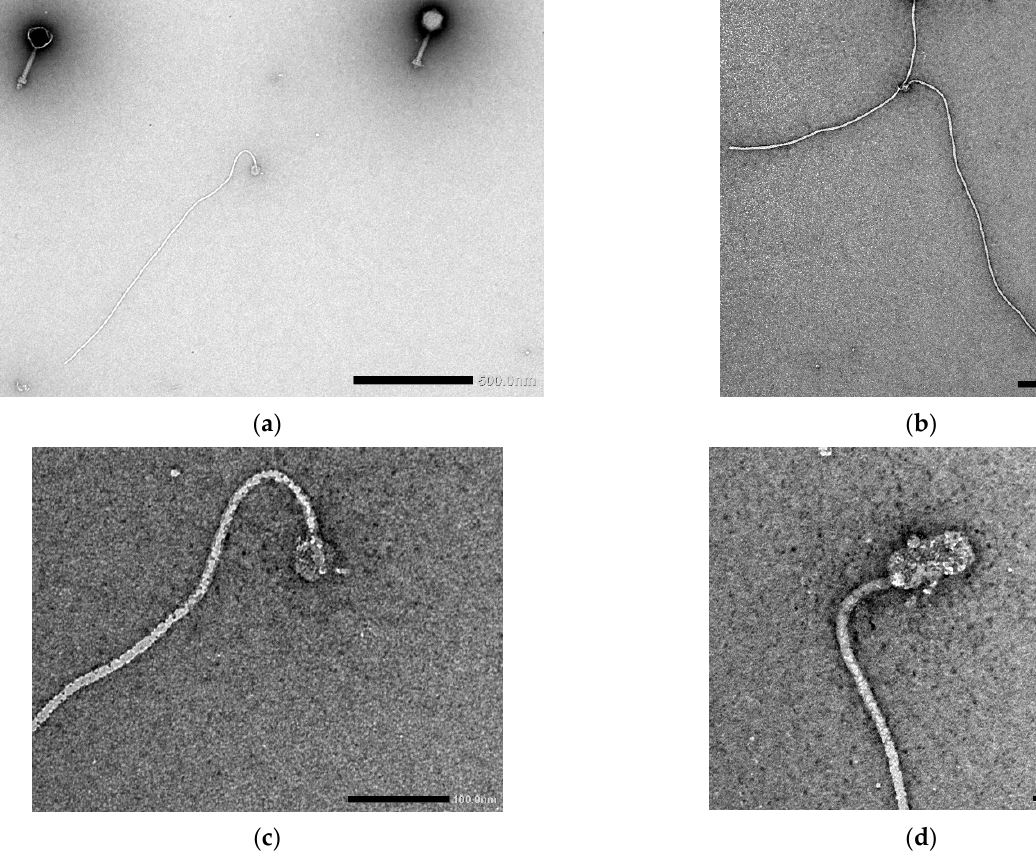
Figure 3. Electron micrographs of 2% ( w/v ) uranyl acetate negatively stained filamentous structures in the original Ps15 phage lysate. Acceleration voltages: ( a ) 15 kV; ( b ) 20 kV; ( c ) 80 kV and ( d ) 100 kV. Scale bars are included in each figure.